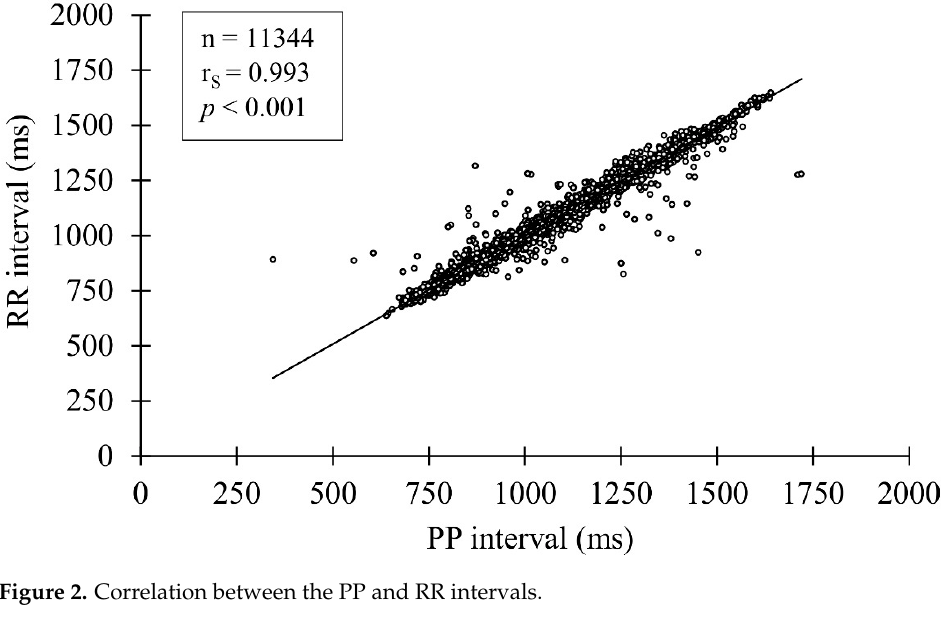
Figure 2. Correlation between the PP and RR intervals.